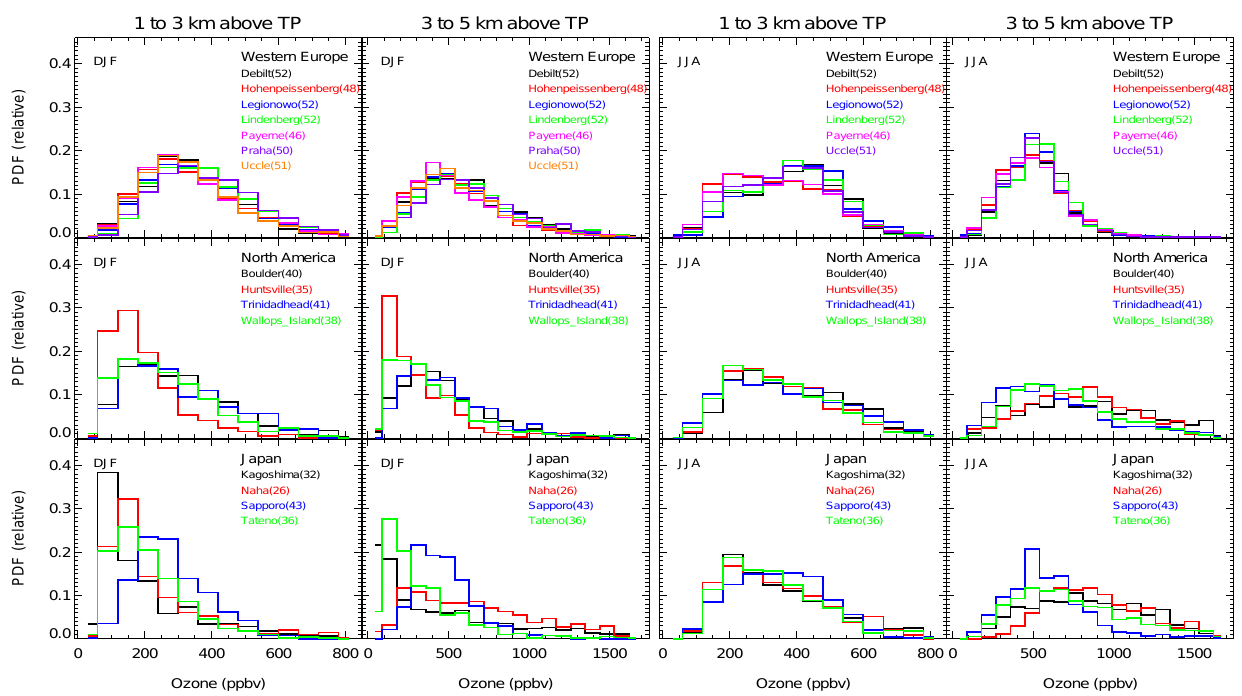
Fig. 10. Probability distribution functions (PDFs) in 1–3km above the TP and in 3–5km above the TP for different stations in Western Europe (top), US (middle), and Japan (bottom), and for winter (first and second column) and summer (third and fourth column). The latitude location of the selected stations is shown in brackets behind the station name.